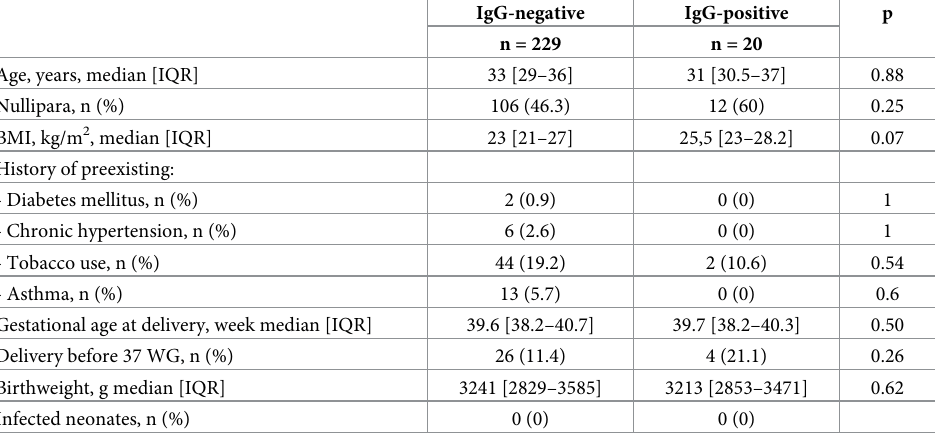
Table 1. Maternal, obstetric and neonatal characteristics according to SARS-CoV-2 serological status for women admitted for